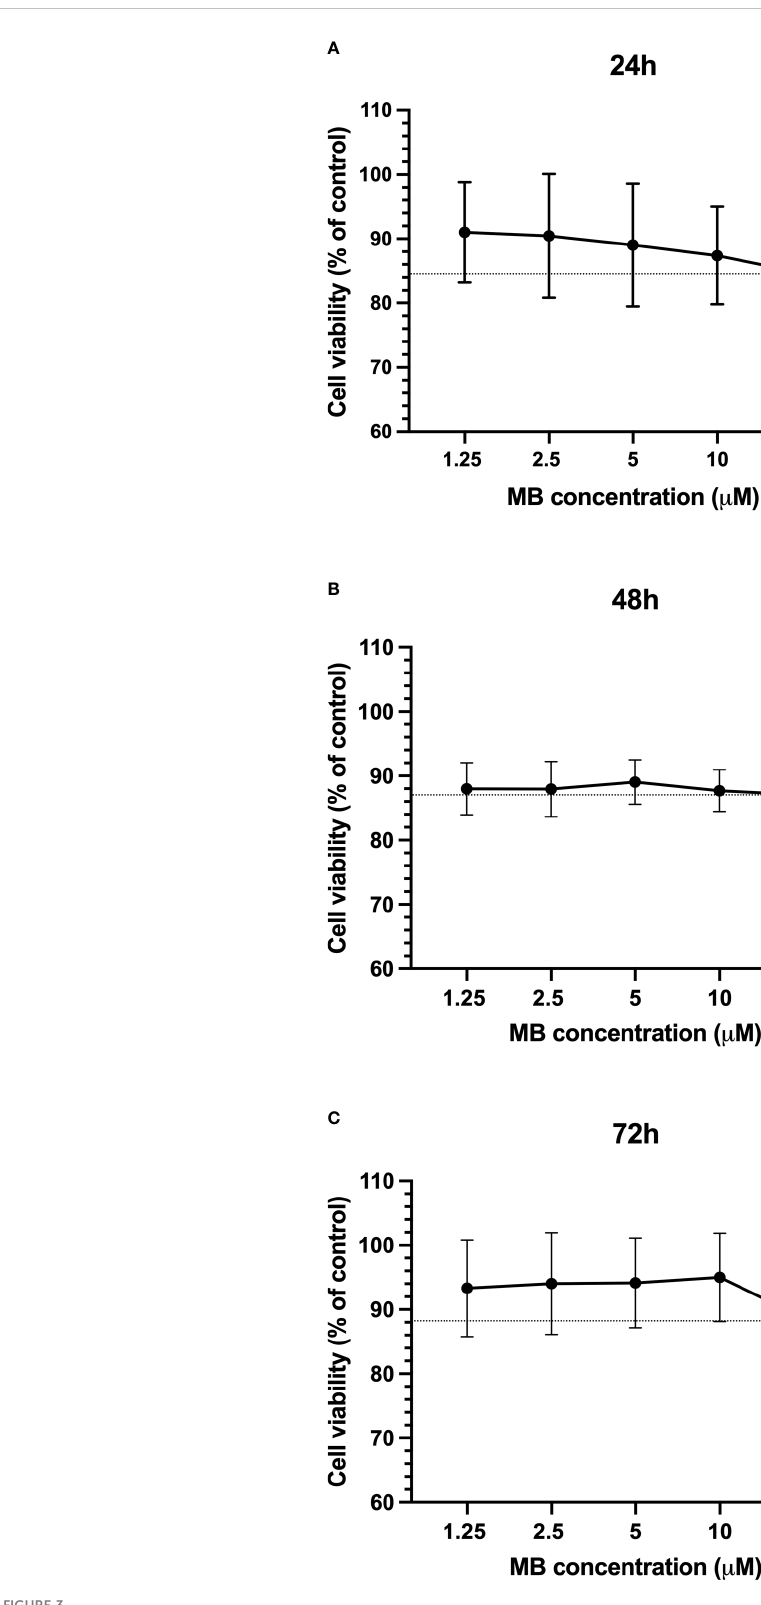
FIGURE 3 MB cytotoxicity on PBMCs. Cell viability of PBMCs presented as a percentage of control after 24h (A) , 48h (B) , and 72h (C) of exposure to different concentrations of MB. The data represent the mean values of three experiments (± SD). The dotted line represents the minimum percentage of cell viability in each exposure